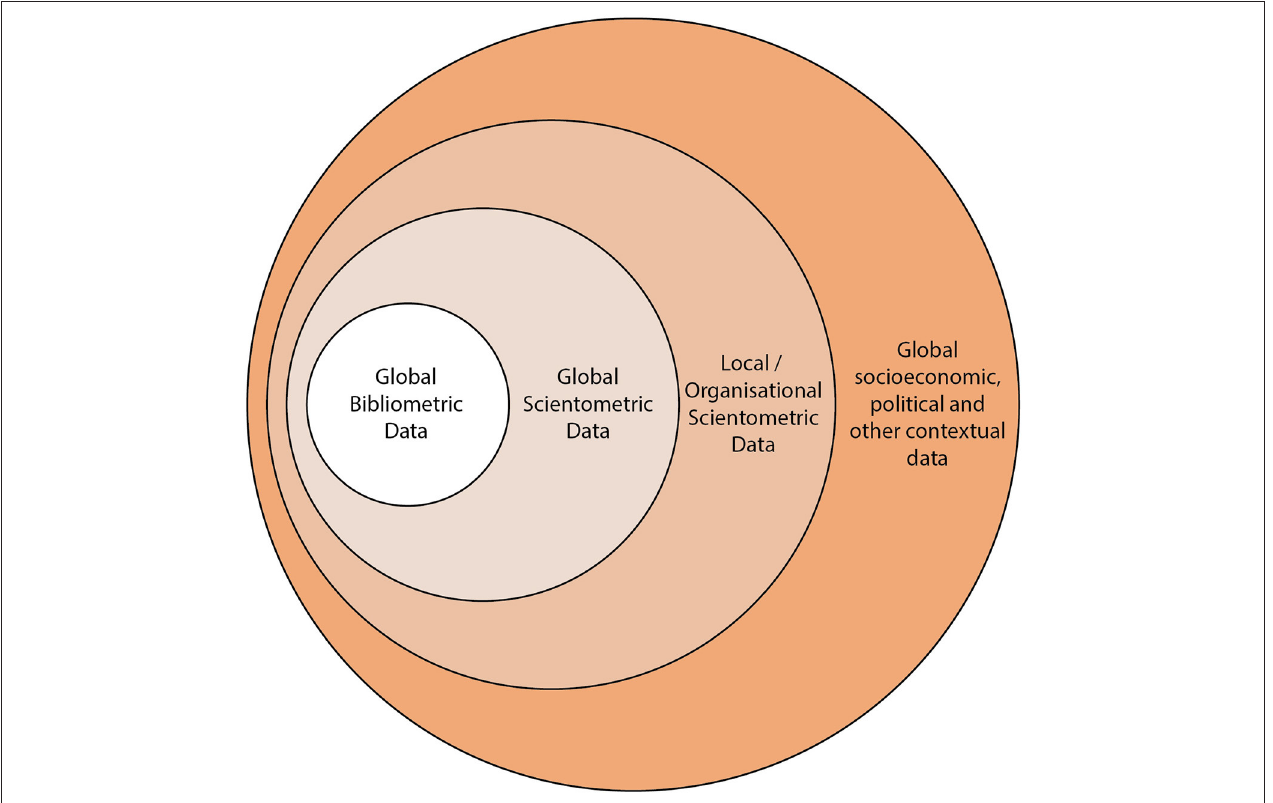
FIGURE 1 | Four modes of data use in scientometrics. The most general data, often used for the purposes of resource planning and policy is Global Bibliometric Data—it consists of the bibliographic data such the co-authorship graph, the locational information regarding journal reference and the geographic information. It is the least detailed data and often has the least coverage to PID infrastructure of the datasets shown in this diagram. Global Scientometric Data extends the Global Bibliometric Data with the citation graph and may include altmetric data, although this could also be argued to sit in the outer circle depending on whether it is viewed as attention or context. Local/Organizational Scientometric Data is the data contained in local CRIS systems or national repositories. This data is often enhanced by curation by institutional, funder-based or academicians themselves. Any of these three inner circles may be enhanced by subject classification or annotation approaches to add new facets to the data. The outer circle contains global socioeconomic, political, and other contextual data, which is not typically viewed as being part of the scientometric world. In these data we include items that may connect scientometric data through place, time, or other locational information the the broad